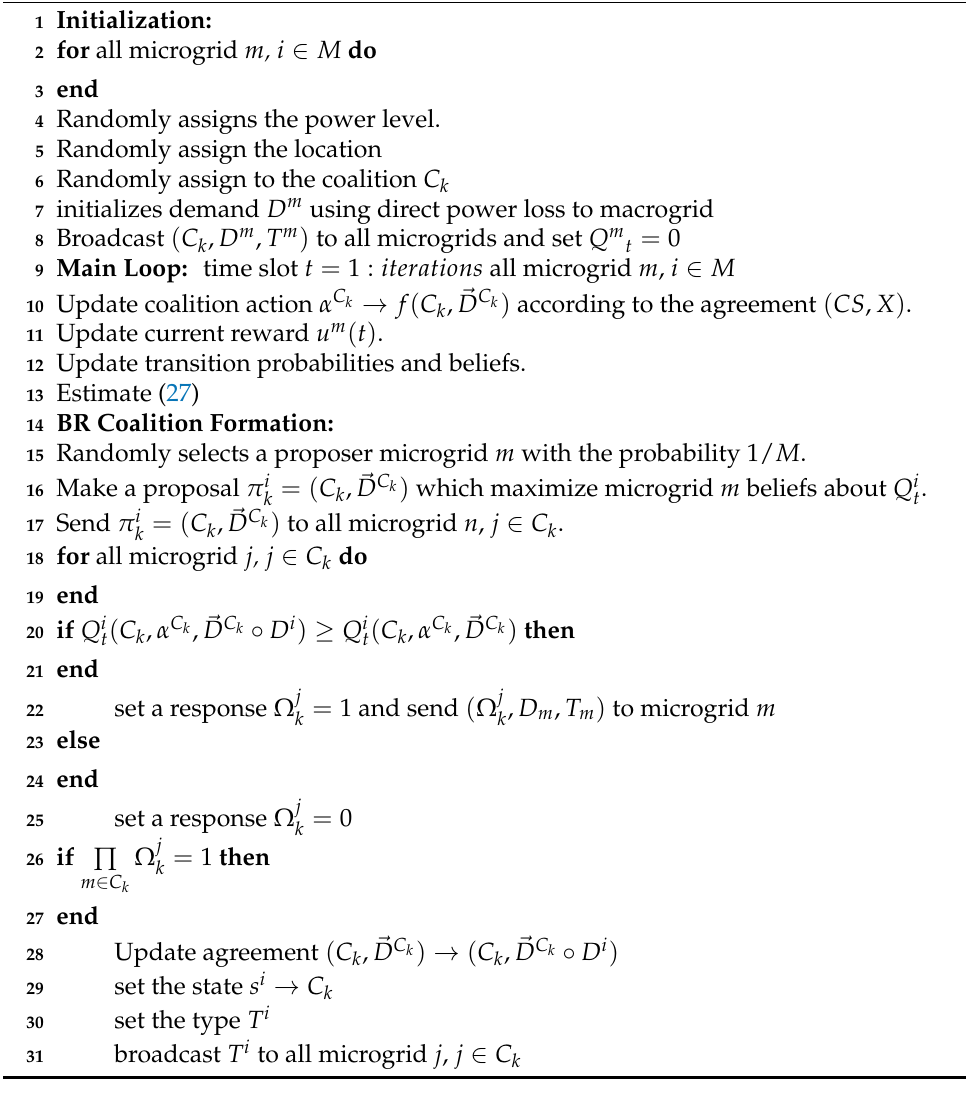
Algorithm 1: Coalition formation with BCRL for distributed energy